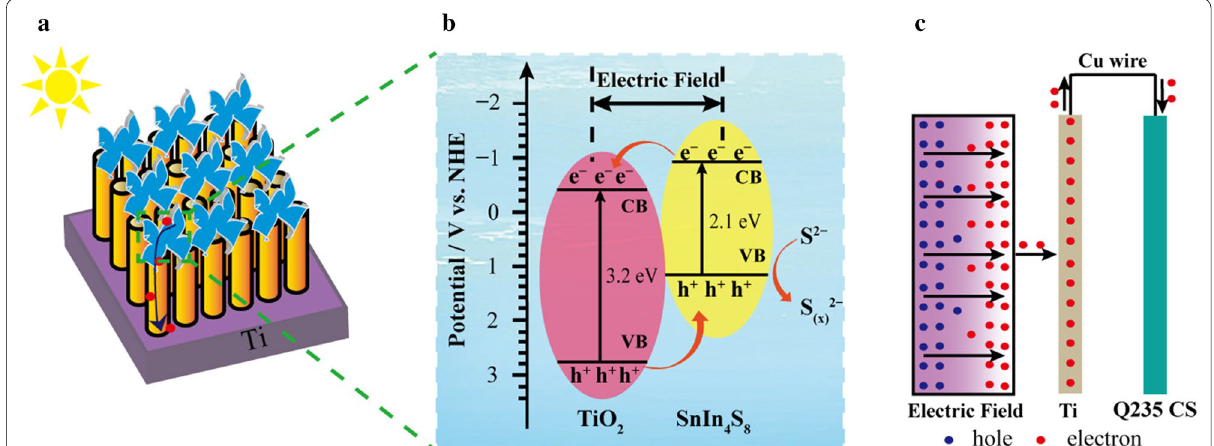
Fig. 11 Proposed mechanisms for the enhanced photocathodic protection performance of the SnIn 4 S 8 /TiO 2 composite for Q235 CS under visible light